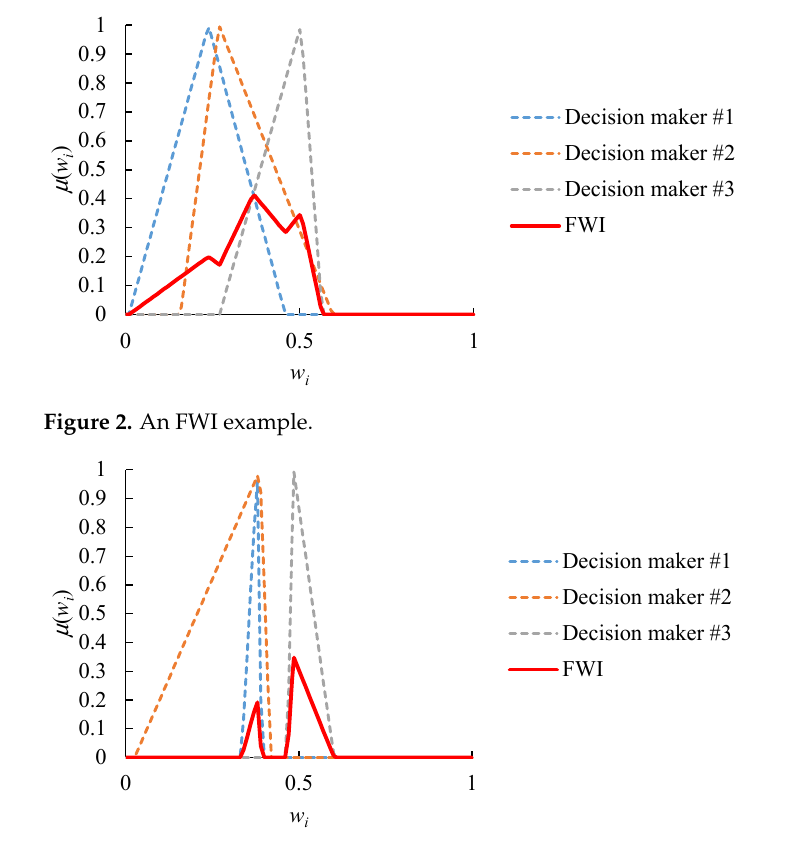
Figure 3. The aggregation result when decision makers lack an overall consensus.